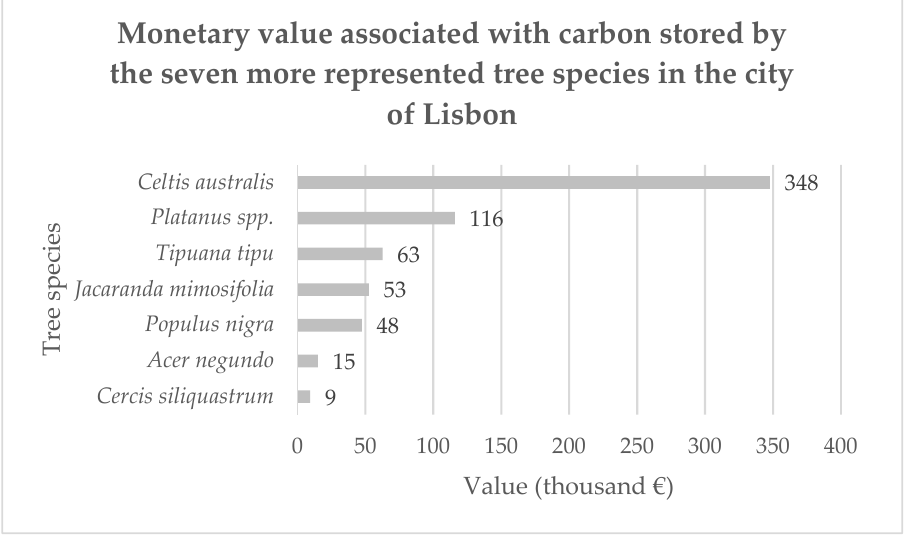
Figure 7. Carbon storage monetary value for each of the tree species in the city of Lisbon.